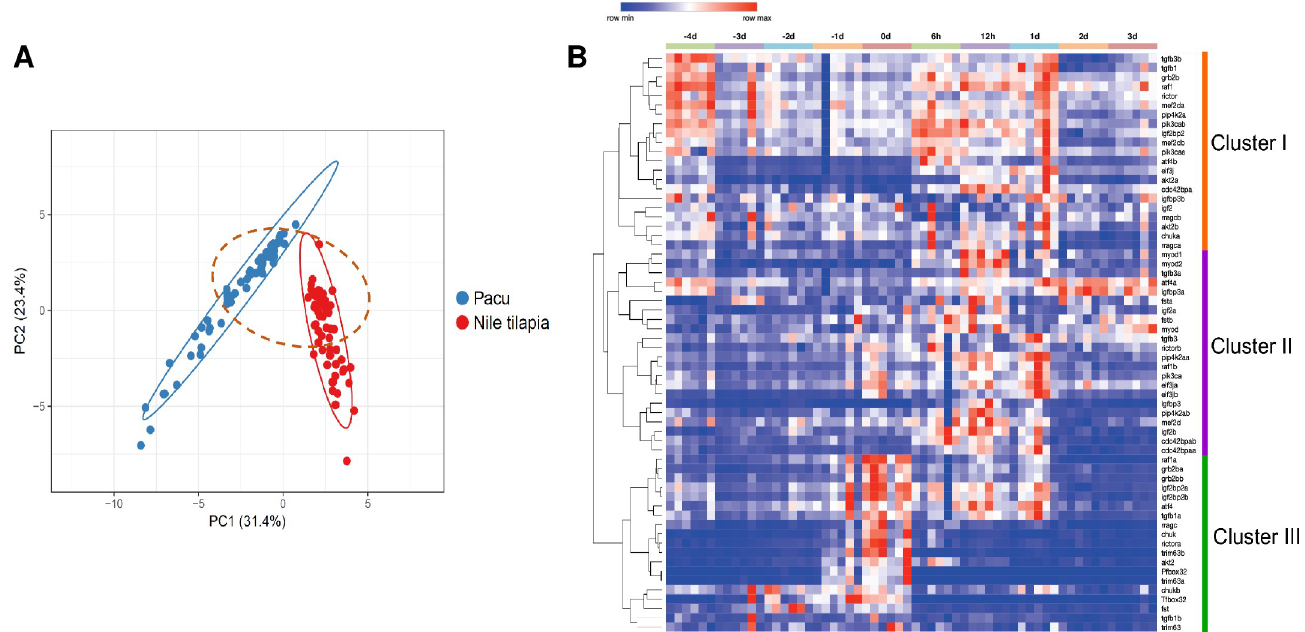
Fig 2. Lineage-specific ohnologs (LSOs) expression between skeletal muscle of pacus and Nile tilapias. (A) Principal component analysis (PCA) showing LSOs expression data grouping according to fish species. Principal components were calculated using the SVD with imputation and Unit Variance Scaling method for row scaling. Prediction ellipses have 0.95 of confidence level. (B) Hierarchical clustering and non-hierarchical K-means clustering (K-means = 3) for pacus and tilapias LSOs and singletons transcription in response to fasting-refeeding. Red indicates high and blue indicates low expression values. Heatmap shows the 2 - Δ Ct values of LSOs expression and One Minus Pearson Correlation was used as metric for